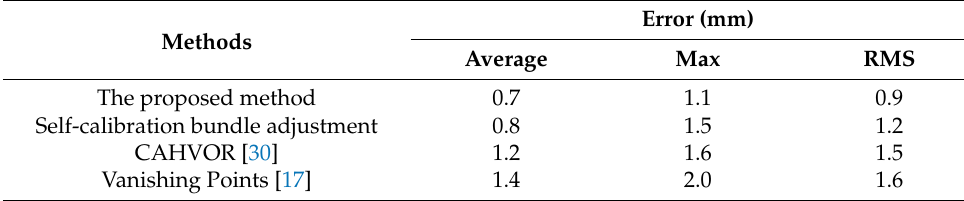
Table 3. Errors of the 20